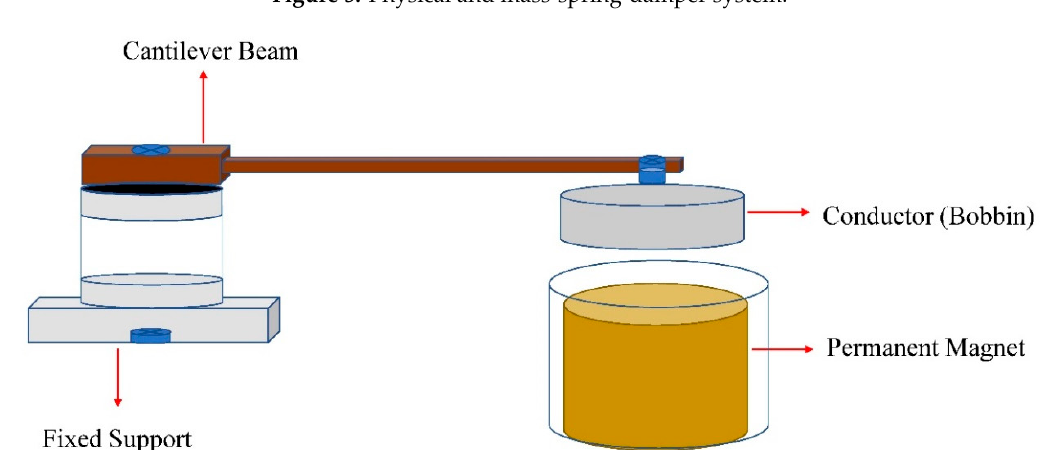
Actuators 2020 , 10 , x FOR PEER REVIEW Figure 5. Physical and mass-spring-damper system.